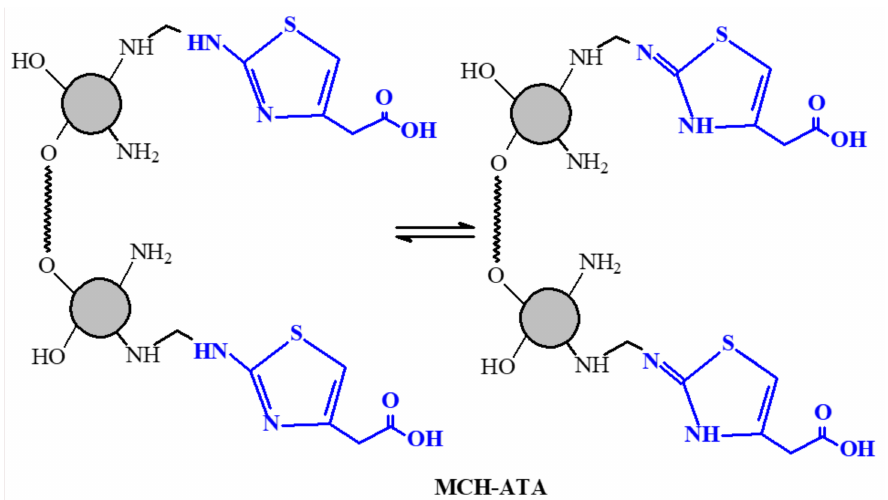
Scheme 2. Tautomeric effect of thiazole ring at slight acidic pH